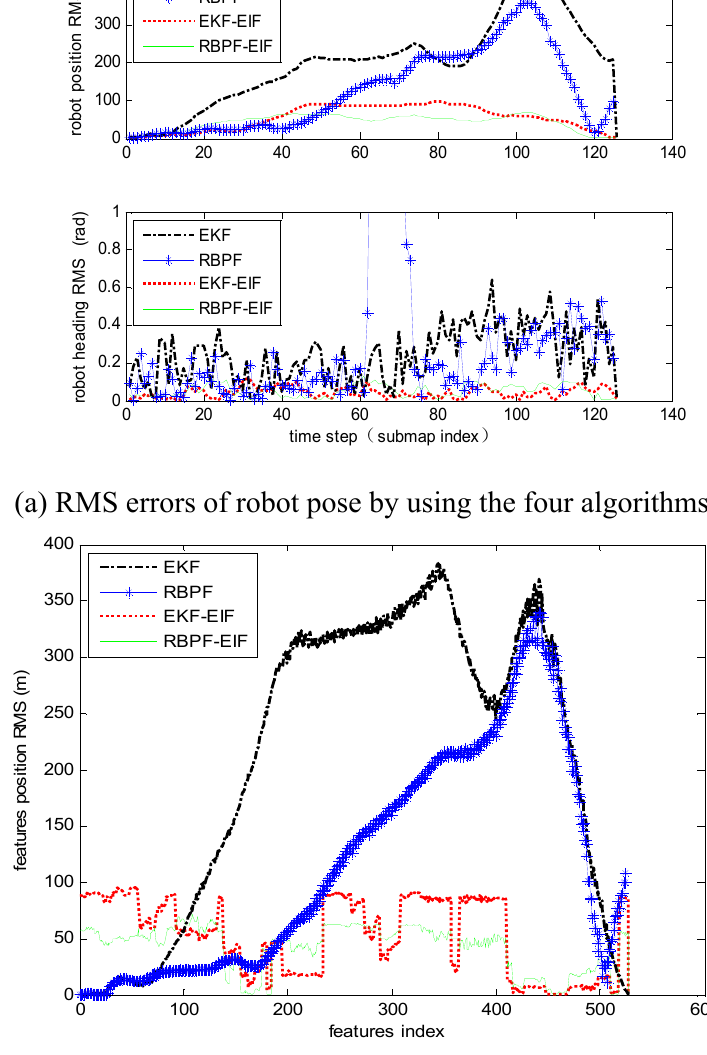
(b) RMS of features by using the four